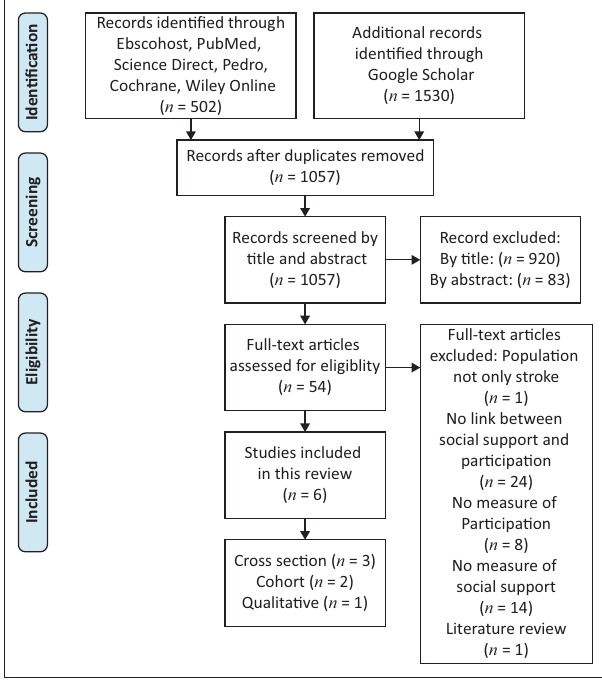
FIGURE 1: Flow diagram of study